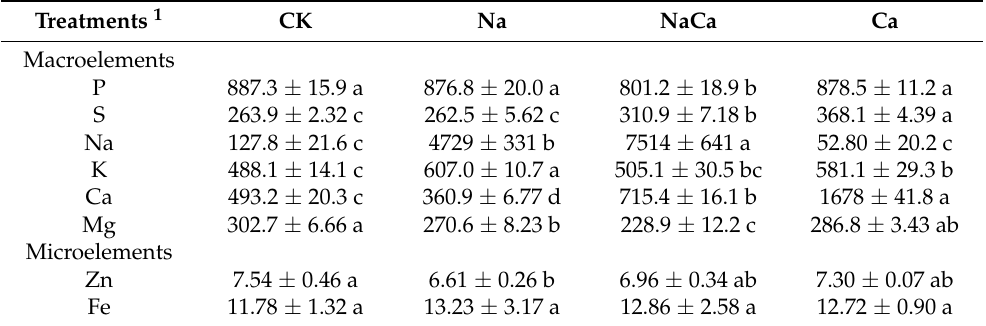
Figure 3. Nitrate content of broccoli microgreens under different treatments. CK, distilled water; Na, 80 mmol/L NaCl; NaCa, 80 mmol/L NaCl + 1.39 mmol/L CaSO 4 ; Ca, 1.39 mmol/L CaSO 4 ; DW, dry weight. Data are expressed as the mean ± standard deviation (SD), values labelled with different letters are significantly different ( p < 0.05). Table 2. Mineral content of broccoli microgreens under different treatments (mg/100 g dry